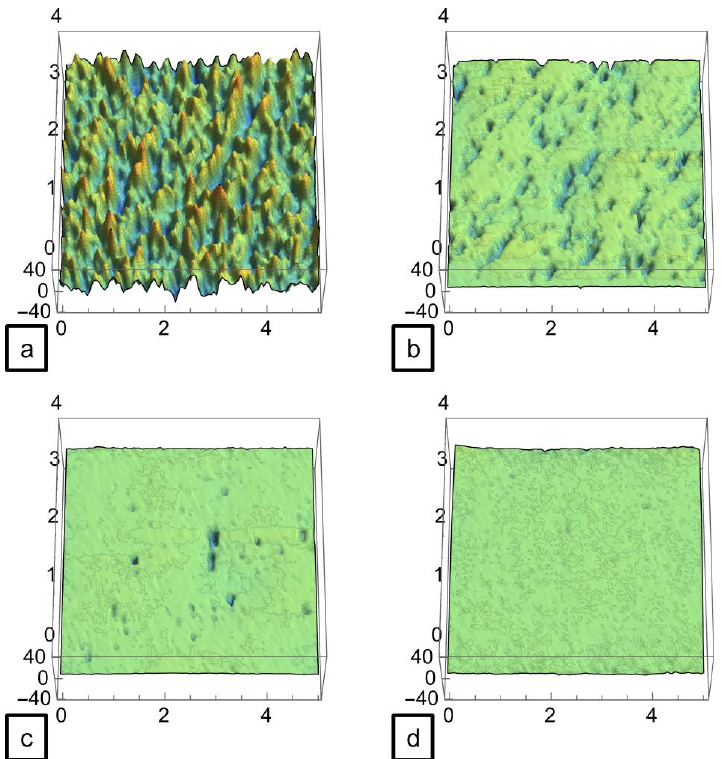
Figure 10. 3D maps of 45° building orientation surfaces before BF ( a ), after 12 h ( b ), after 24 h ( c ), and after 48 h ( d ) working time.